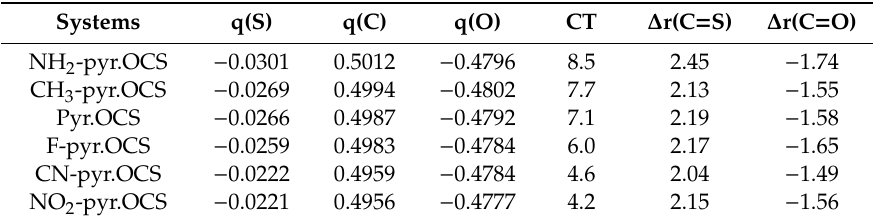
Table 7. NBO charges on the S, C, and O atoms (e), charge transfer from pyridine to OCS (me) and variation of the C = S and C = O distances (mÅ) in the B -pyridines.OCS